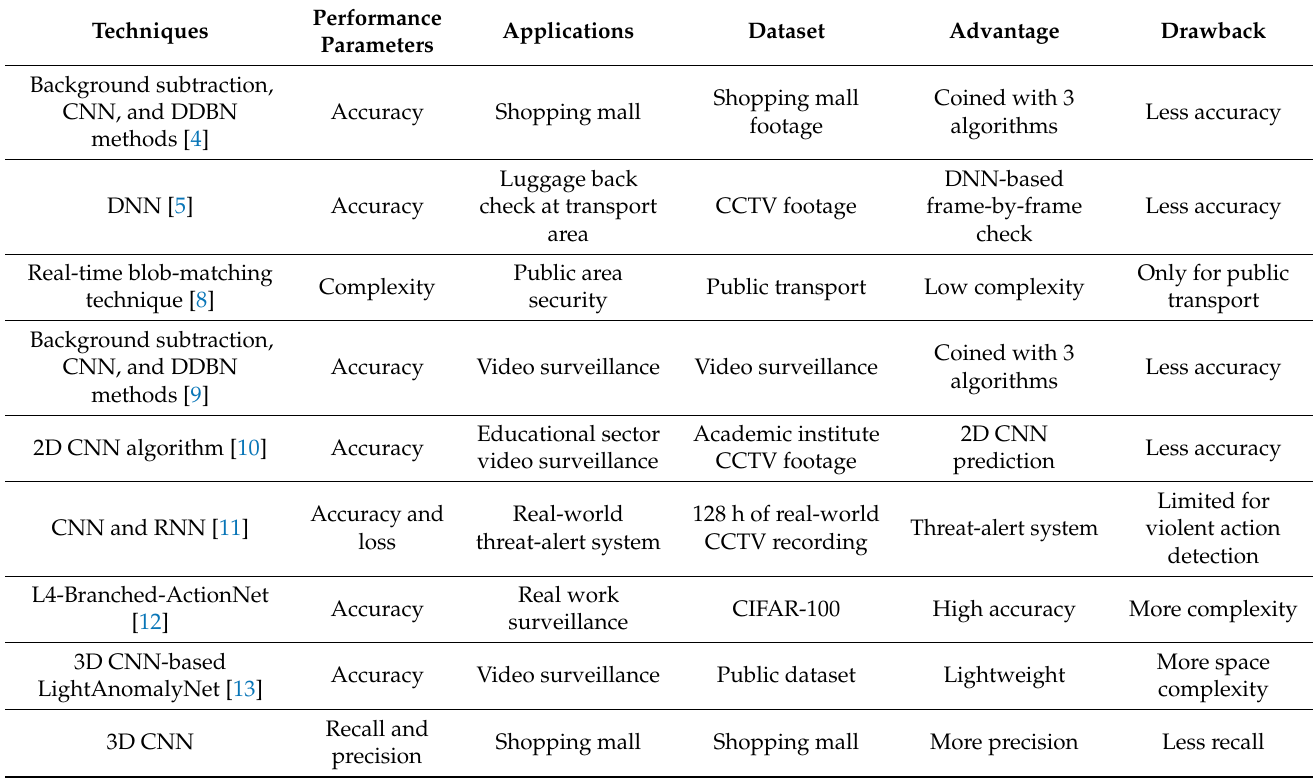
Table 1. Comparison of different techniques for suspicious-action